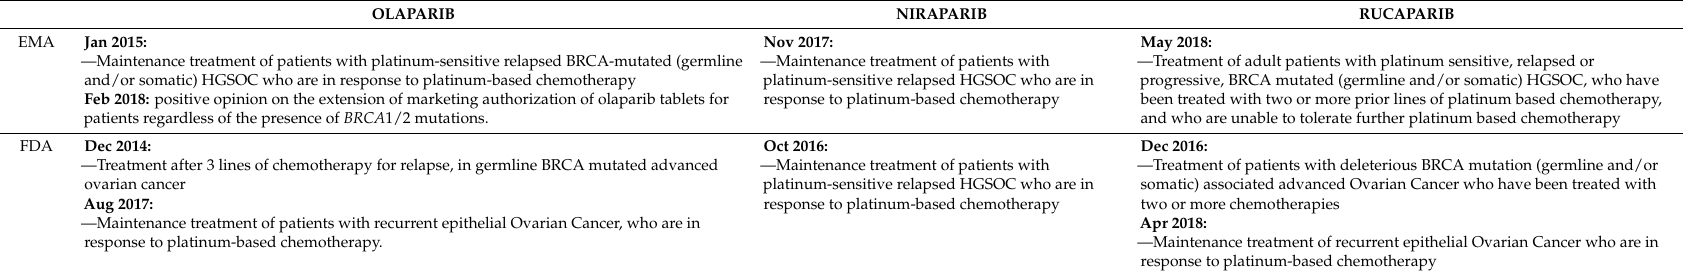
Table 1. History of PARPi approvals in ovarian